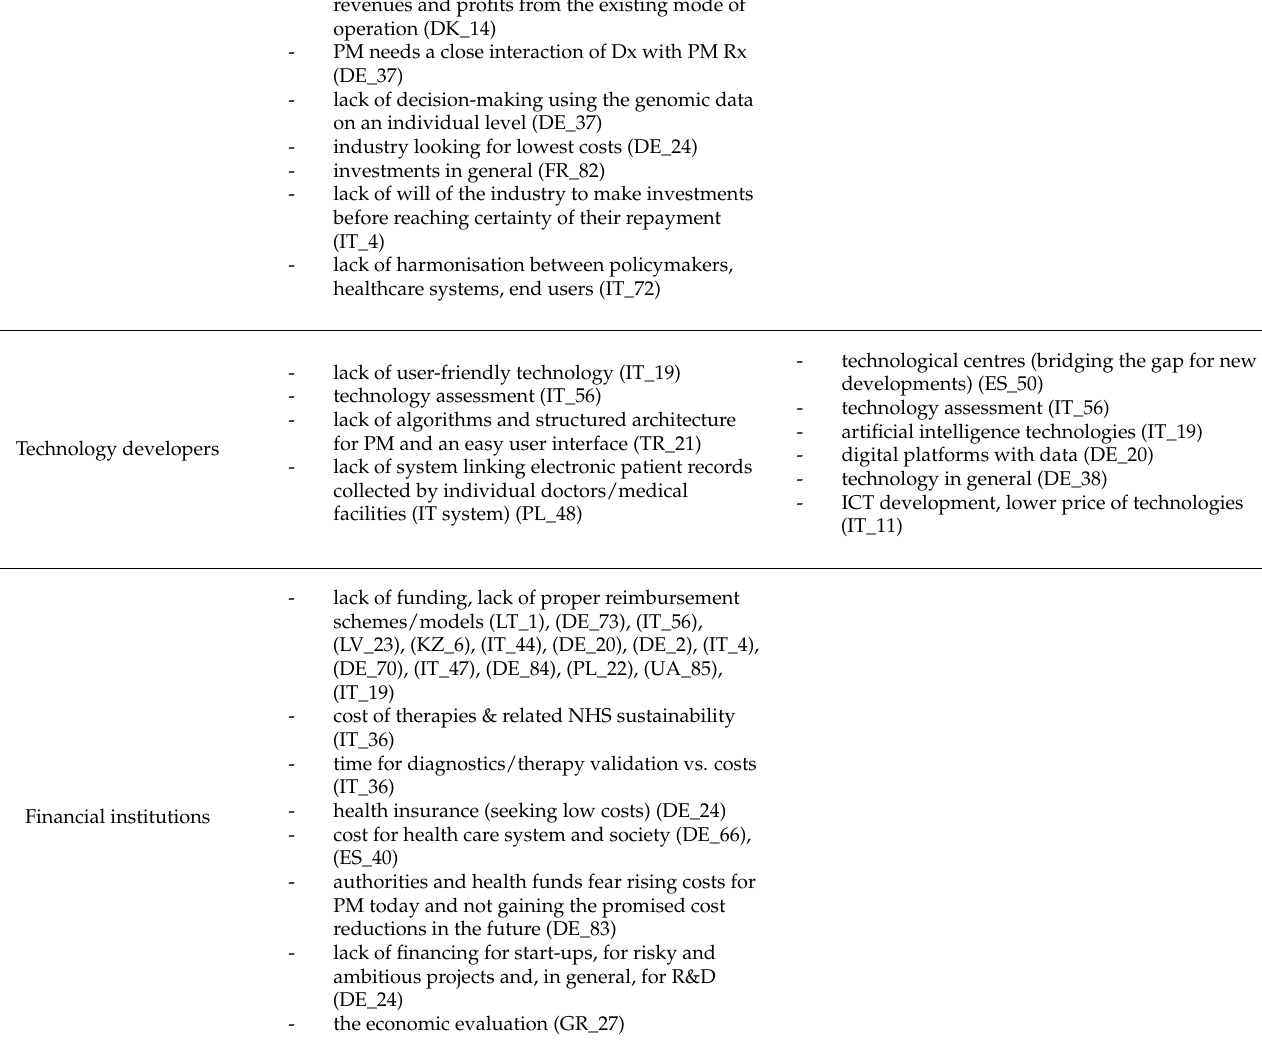
Table 2. Cont. Barriers to the Implementation of PM Interventions